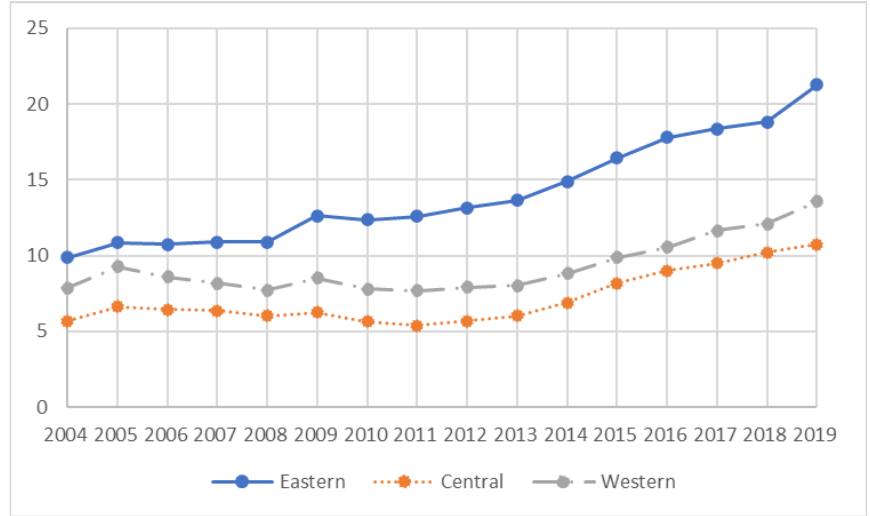
Figure 2. Change trend of industrial structure in three regions of China.